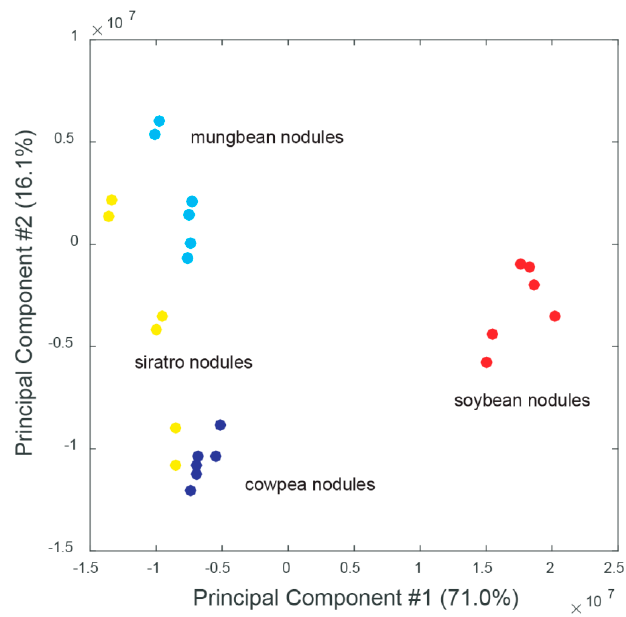
Figure 1. Principal component analysis (PCA) of metabolome datasets obtained from soybean (red); mungbean (light blue); cowpea (blue) and siratro (yellow) root nodules. Three biological replicates were examined, each analyzed twice by non-targeted metabolomics; #: number.